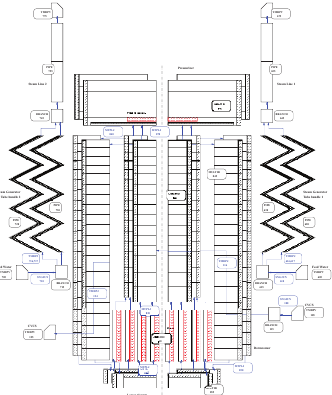
Fig. 9. NuScale RPV three-dimensional model for RELAP- 3D developed by UJV